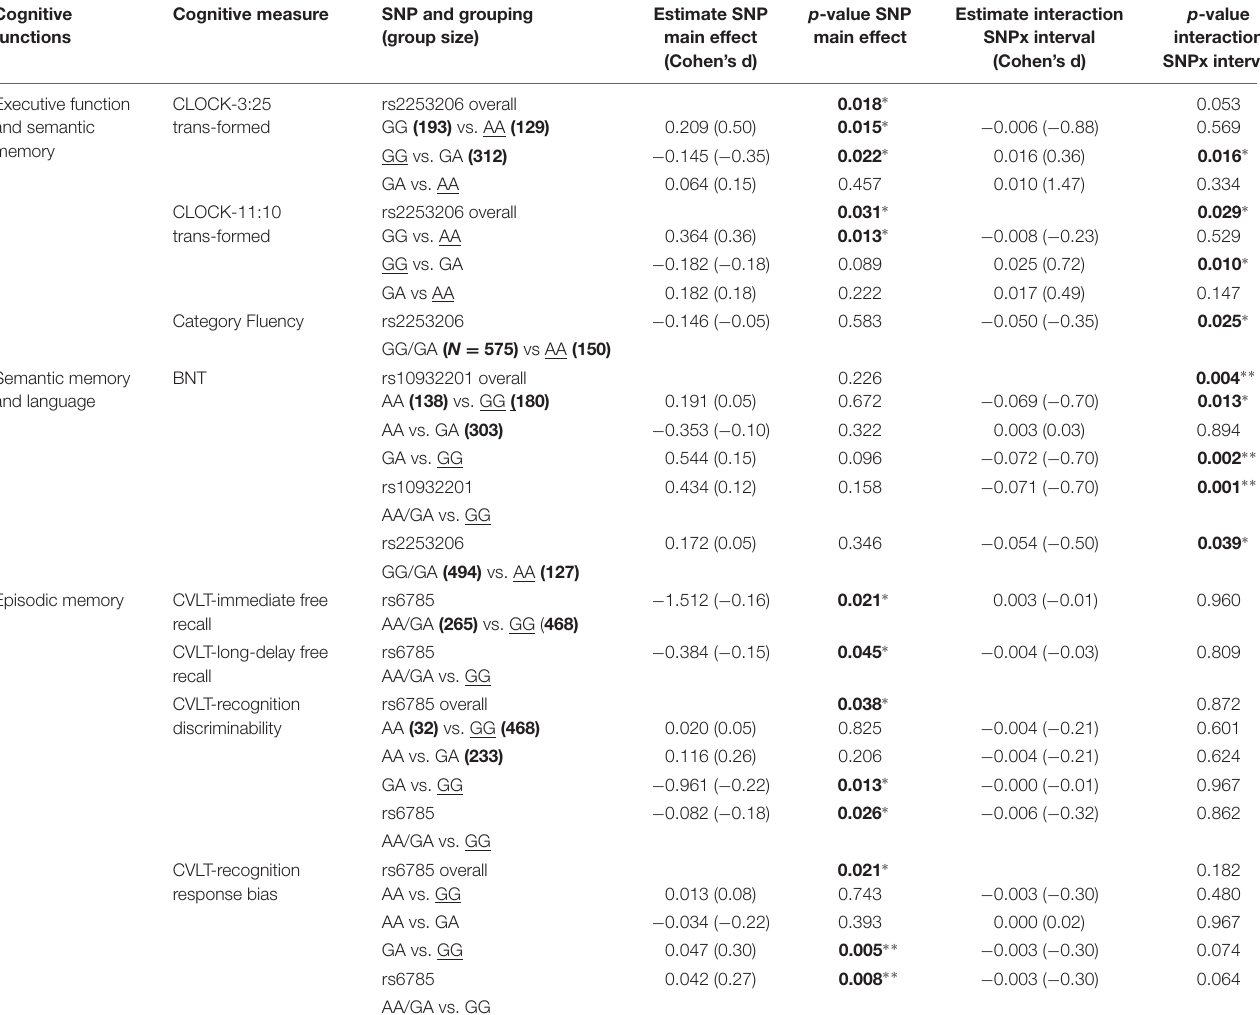
TABLE 1 | Cross-sectional and longitudinal effects of CREB1 genotypes on cognitive measures controlling for baseline age, sex, APOE ε 4 status, and education. Cognitive